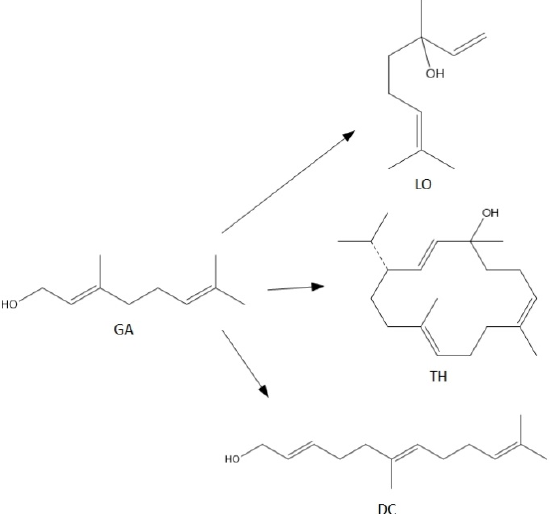
Figure 10. The main reactions describing process of transformations of geraniol in the presence of alum.